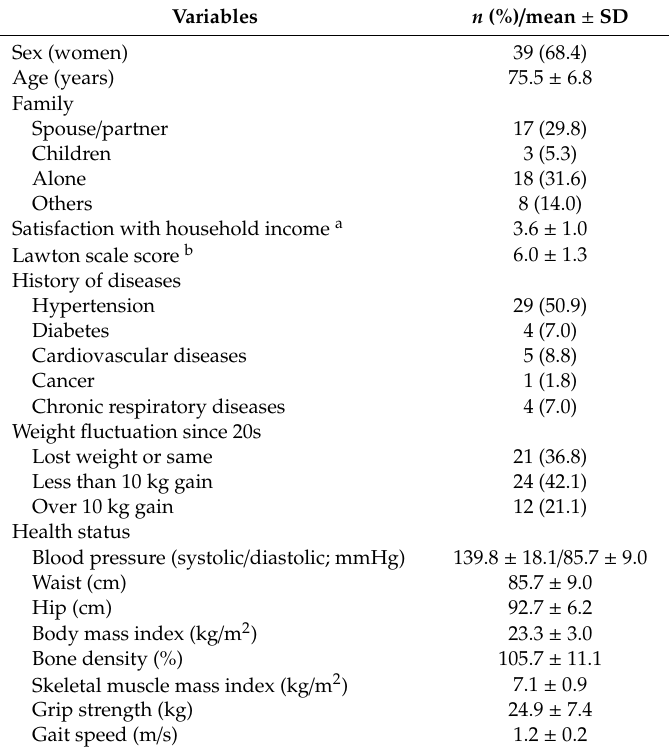
Table 1. Characteristics of 57 Japanese older